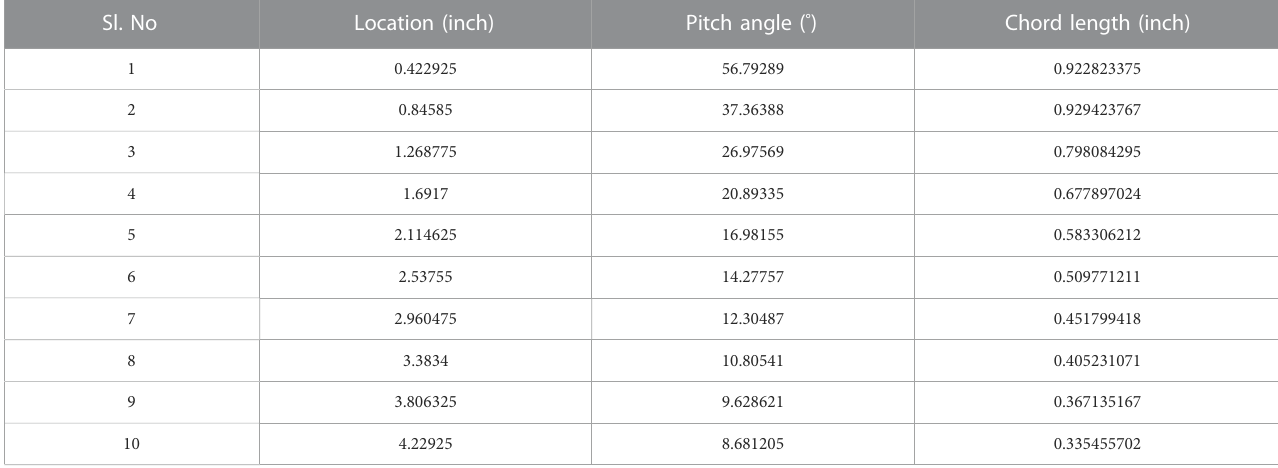
TABLE 2 Estimation of Pitch angle & Chord length of Tail rotor blade. Sl. No